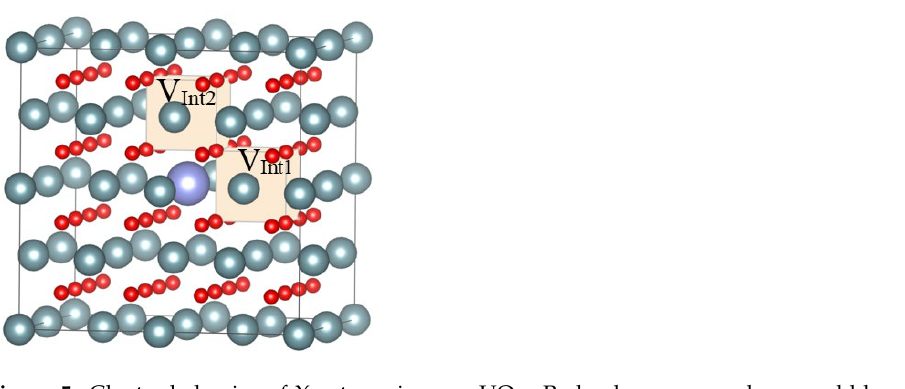
Figure 5. Cluster behavior of Xe atoms in pure UO 2 . Red sphere, grey sphere, and blue sphere represent oxygen atom, uranium atom, and Xe atom, respectively. Yellow represents the volume of the interstitial site. Table 5. Relationship between binding energy (eV) and number of Xe atoms in pure UO 2 , UO 2 -Th, Table 6. Cluster behavior of Xe atoms in pure UO 2 results in a volume change of interstitial UO 2 -Zr, and UO 2 -Ti systems.